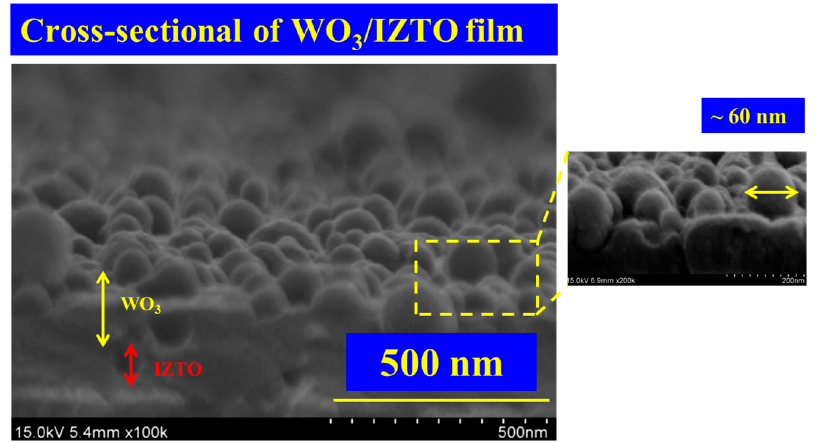
Figure 2. Cross-sectional of WO 3 /IZTO film.